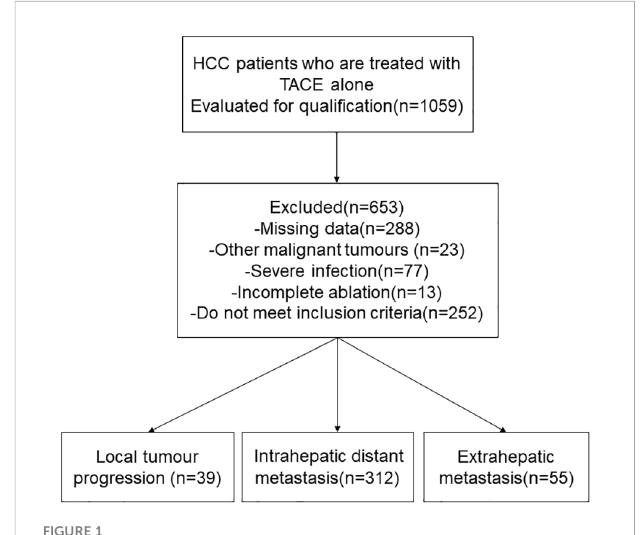
FIGURE 1 Flow chart shows the screening procedure for patients with hepatocellular carcinoma